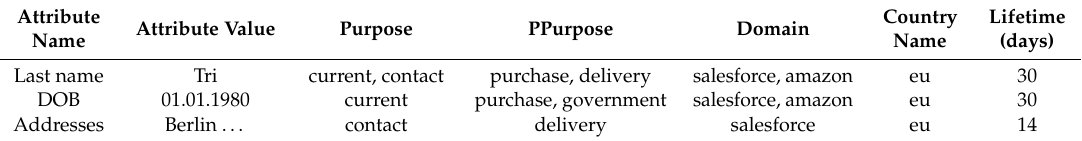
Table 1. Sample user data.